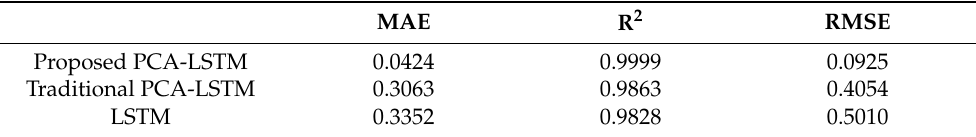
Table 2. Results analysis of the comparative